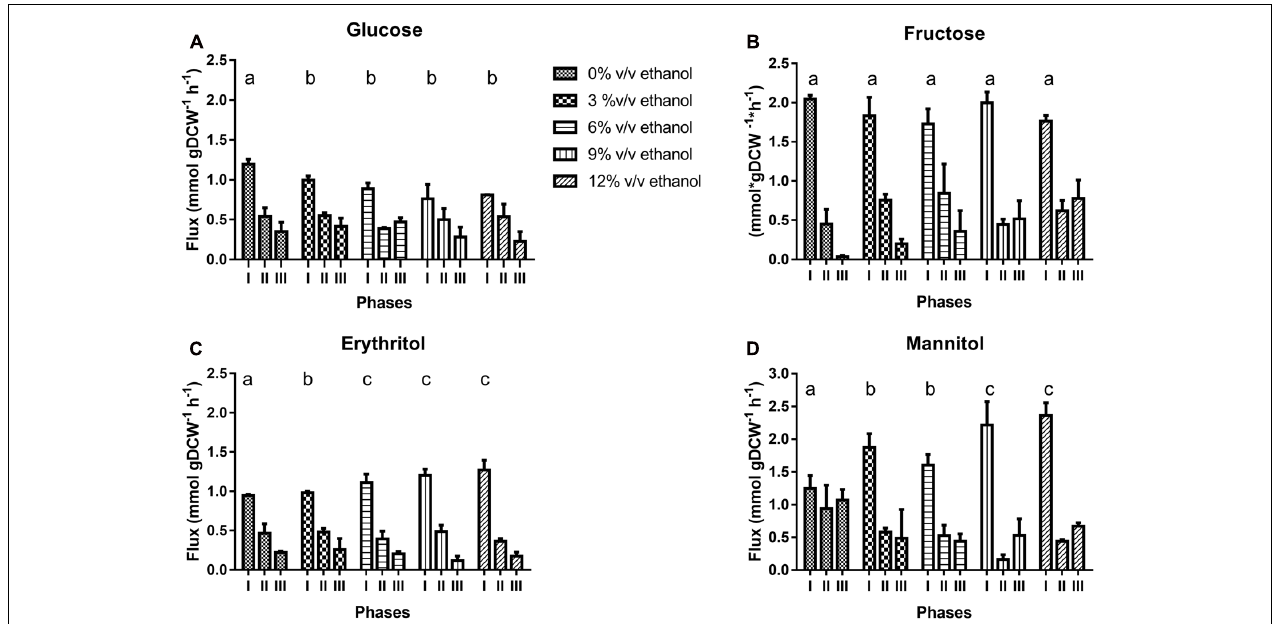
FIGURE 3 | Specific consumption of glucose (A) , and fructose (B) and concomitant specific production of the related products, erythritol (C) and mannitol (D) . during cultivation of O. oeni PSU-1 under increasing ethanol contents. Statistical analysis only was performed in phase I and shared letters indicate no significant difference (Mood test, p <